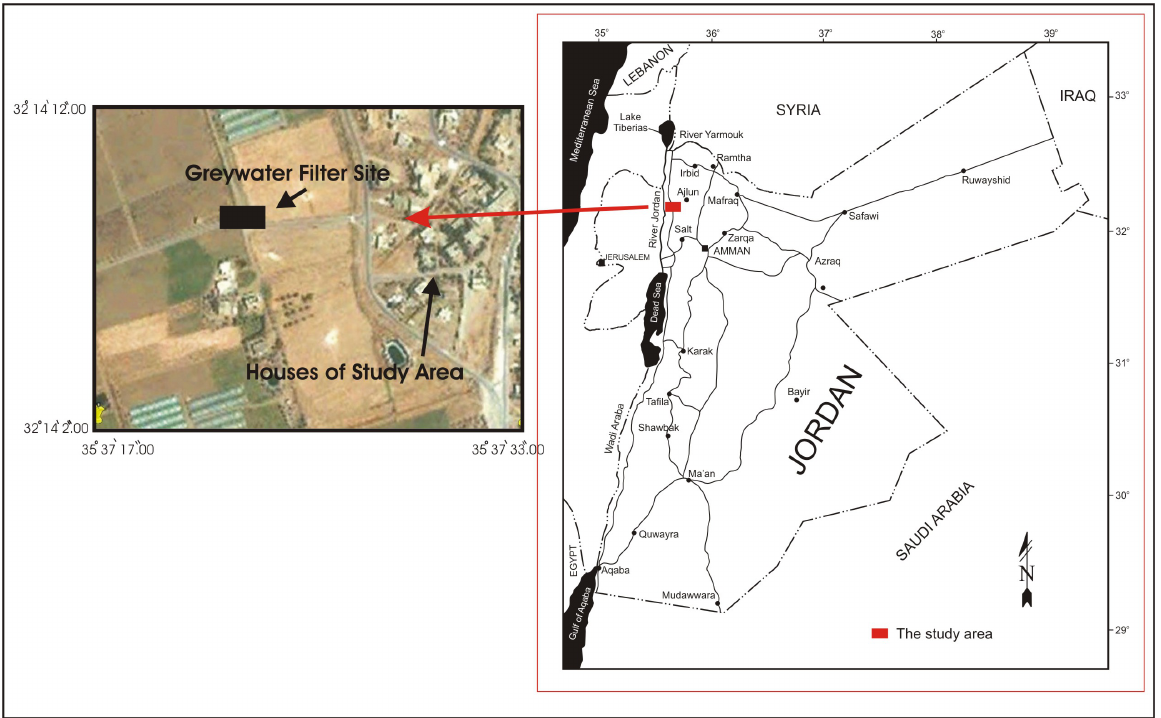
Figure 1. Location map of the studied area, DeirAlla, Jordan (Um-Ayyaash